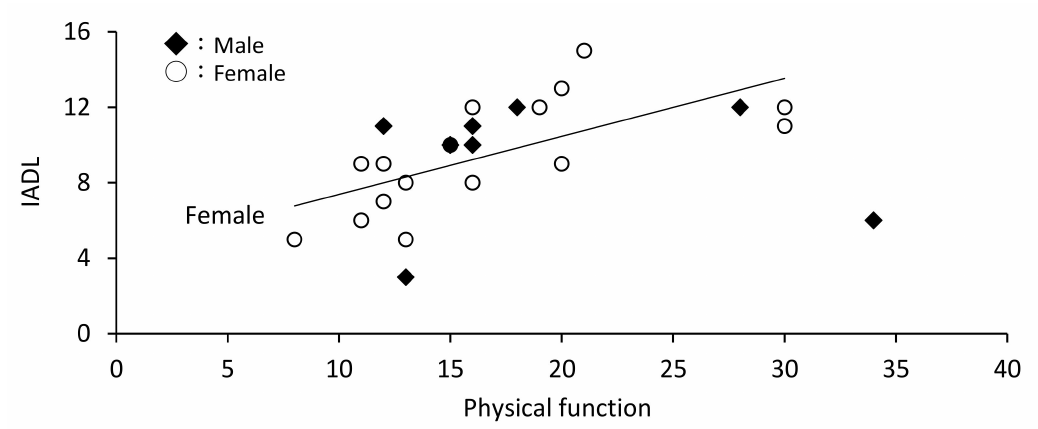
Figure 3. Association between physical function and instrumental activities of daily living (IADL) by